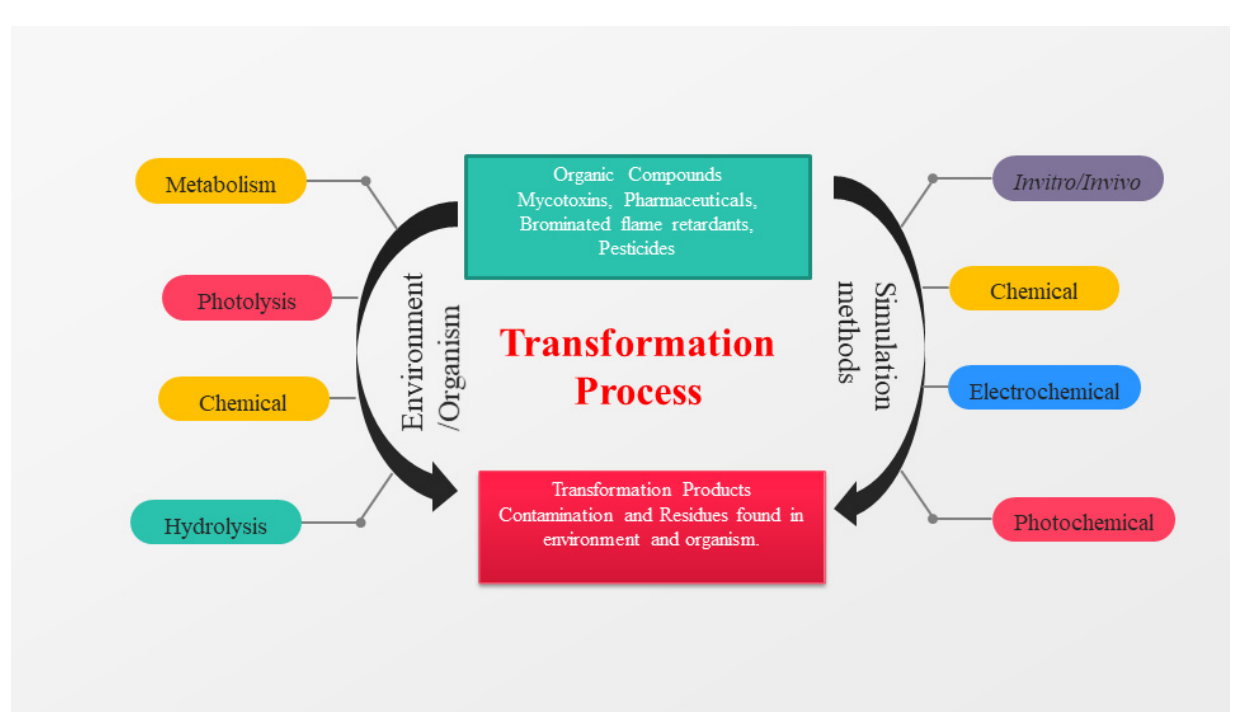
Figure 1. A diagram depicting the transformation processes that occur in organic compounds. General transformation processes in organisms and their environments are represented on the left, while the most frequent simulation approaches are shown on the right.